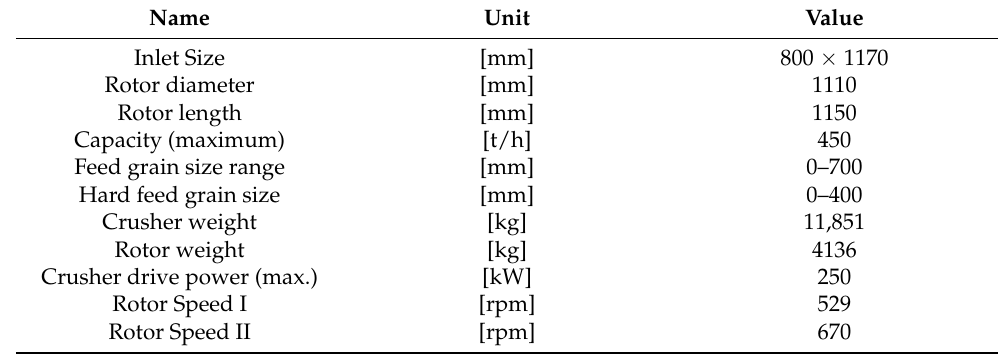
Table 2. Characteristics of the KU 80/120